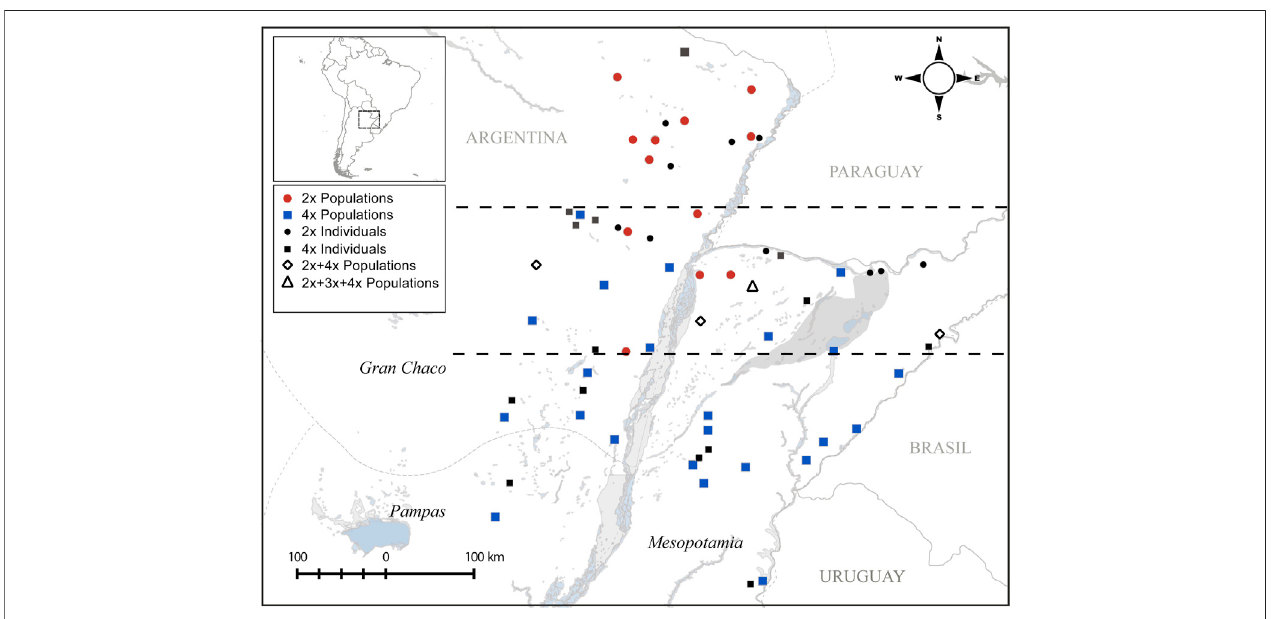
FIGURE 1 | Collection locations of studied P. intermedium populations and their ploidy levels (adopted from Karunarathne et al., 2018). The dashed lines demarcate the contact zone of cytotypes in the middle separating the north and south diploid and tetraploid distribution zones, respectively.